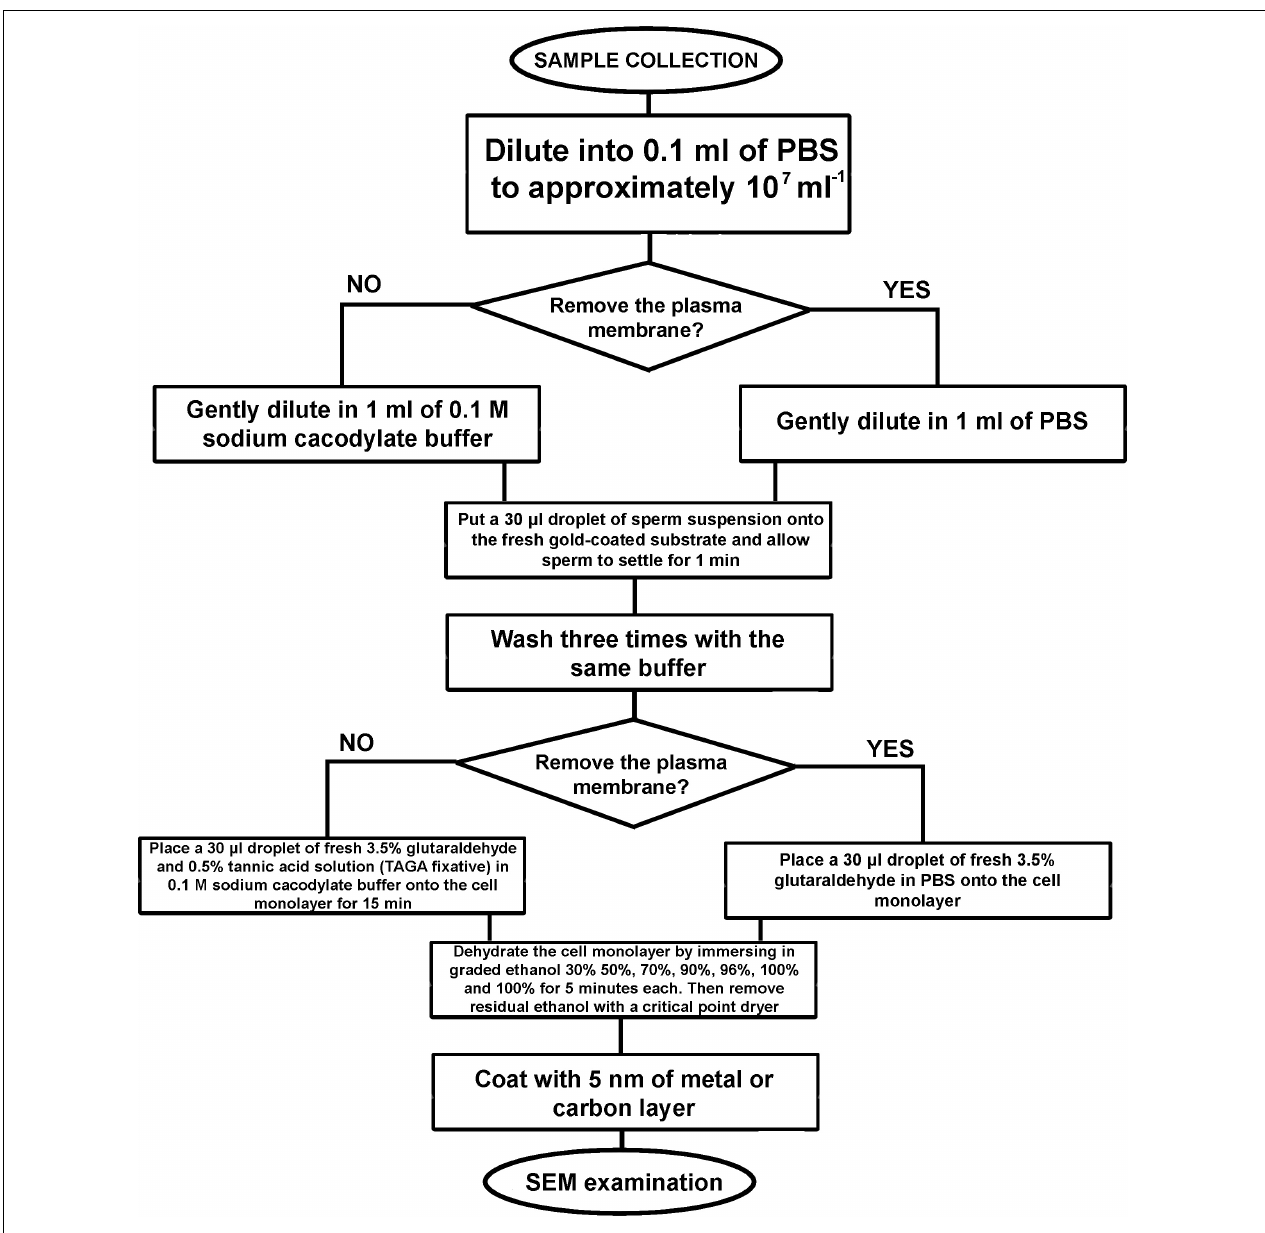
FIGURE 4 | An algorithm of the developed sample preparation protocol for SEM examination of sperm external morphology.